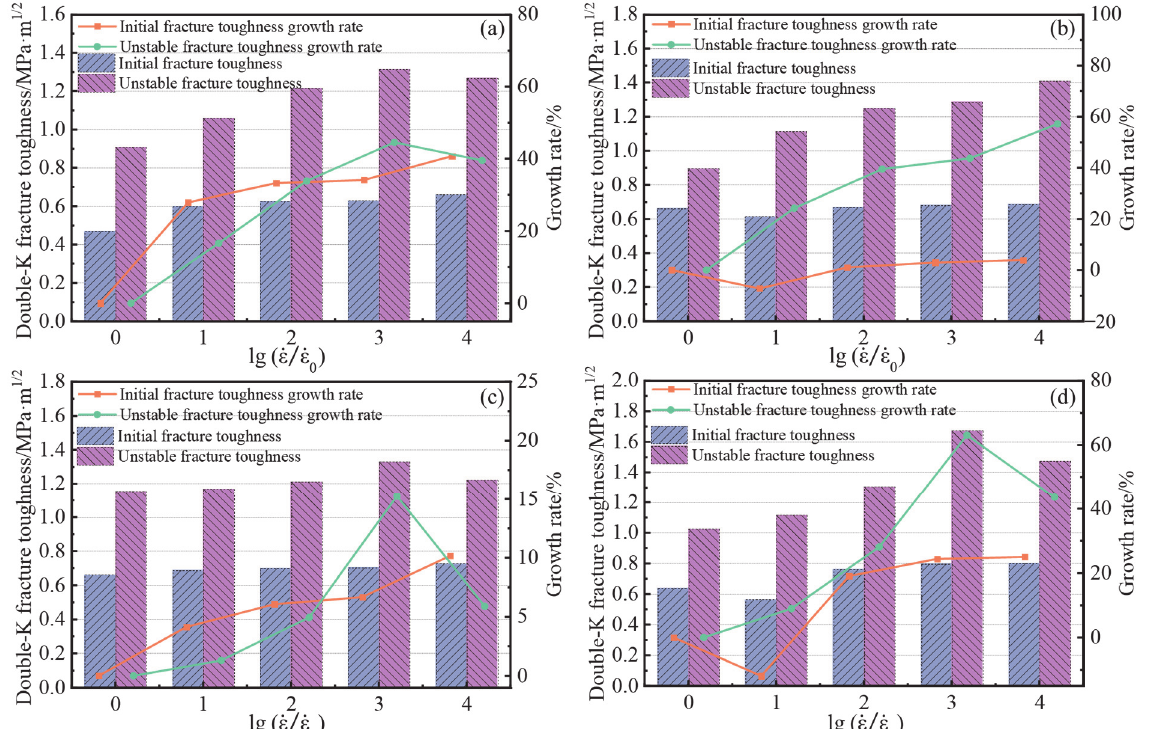
Figure 10. The relationship between the double K fracture toughness and strain rate: ( a ) OPC; ( b ) B ‐ 0.2; ( c ) B ‐ 0.4; and ( d ) B ‐ 0.6. ( b ) B-0.2; ( c ) B-0.4; and ( d )